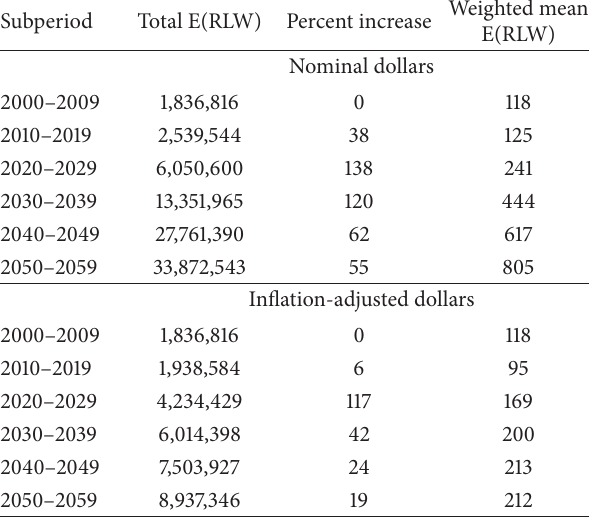
Table 3: Nominal and inflation-adjusted simulated total E(RLW) and weighted mean E(RLW) for residential properties in the Flathead County WUI, by subperiod.